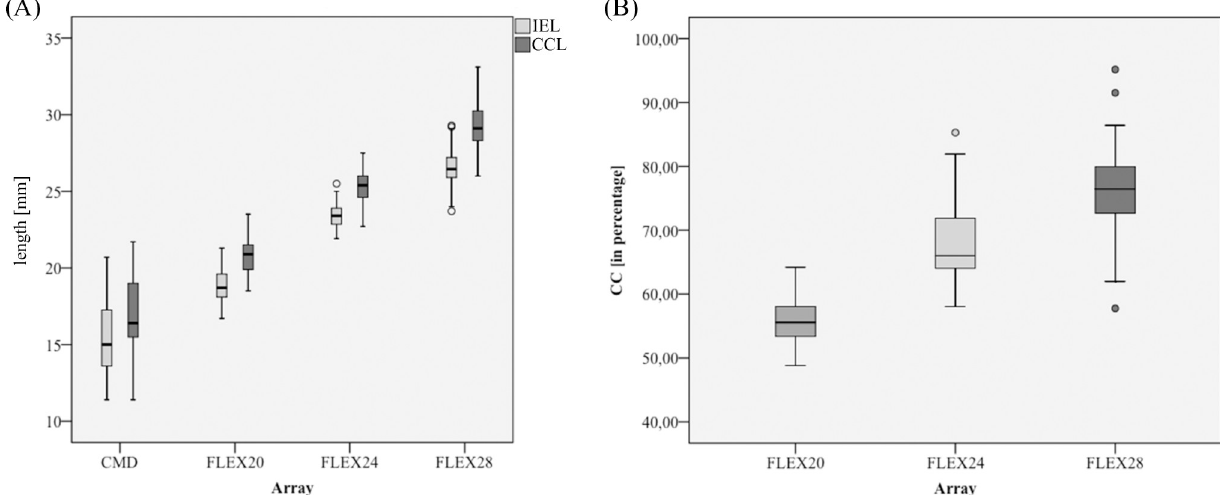
Fig 7. Distribution of electrode specific CI outcomes. (A) IEL and CCL distribution as well as (B) CC ranges for the different electrode array groups.